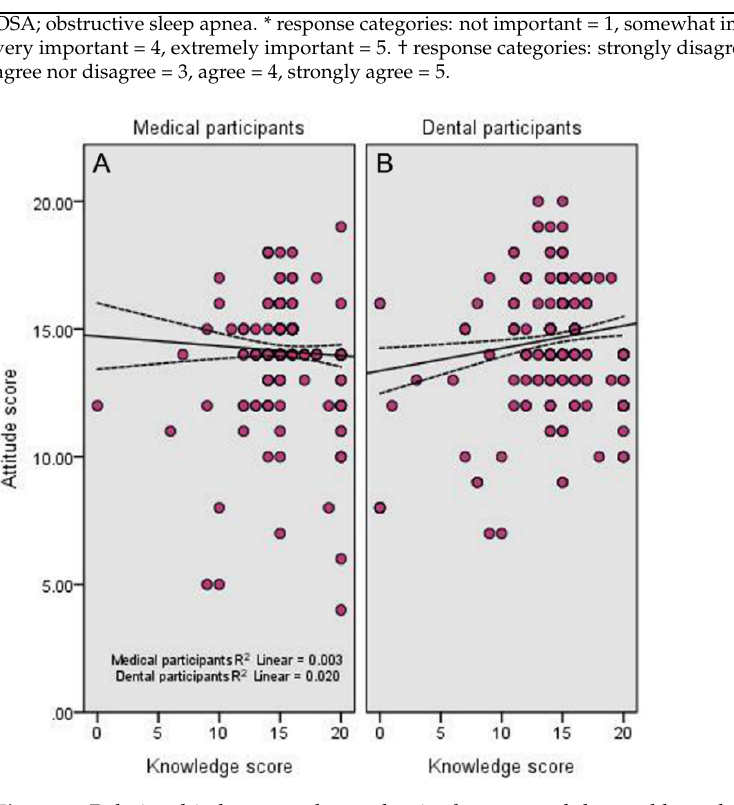
Figure 1. Relationship between the total attitude score and the total knowledge score of ( A ) medical participants and ( B ) dental participants. The middle lines show the line of best fit for the correlation and the two lateral lines show the 95% confidence intervals for the mean values.